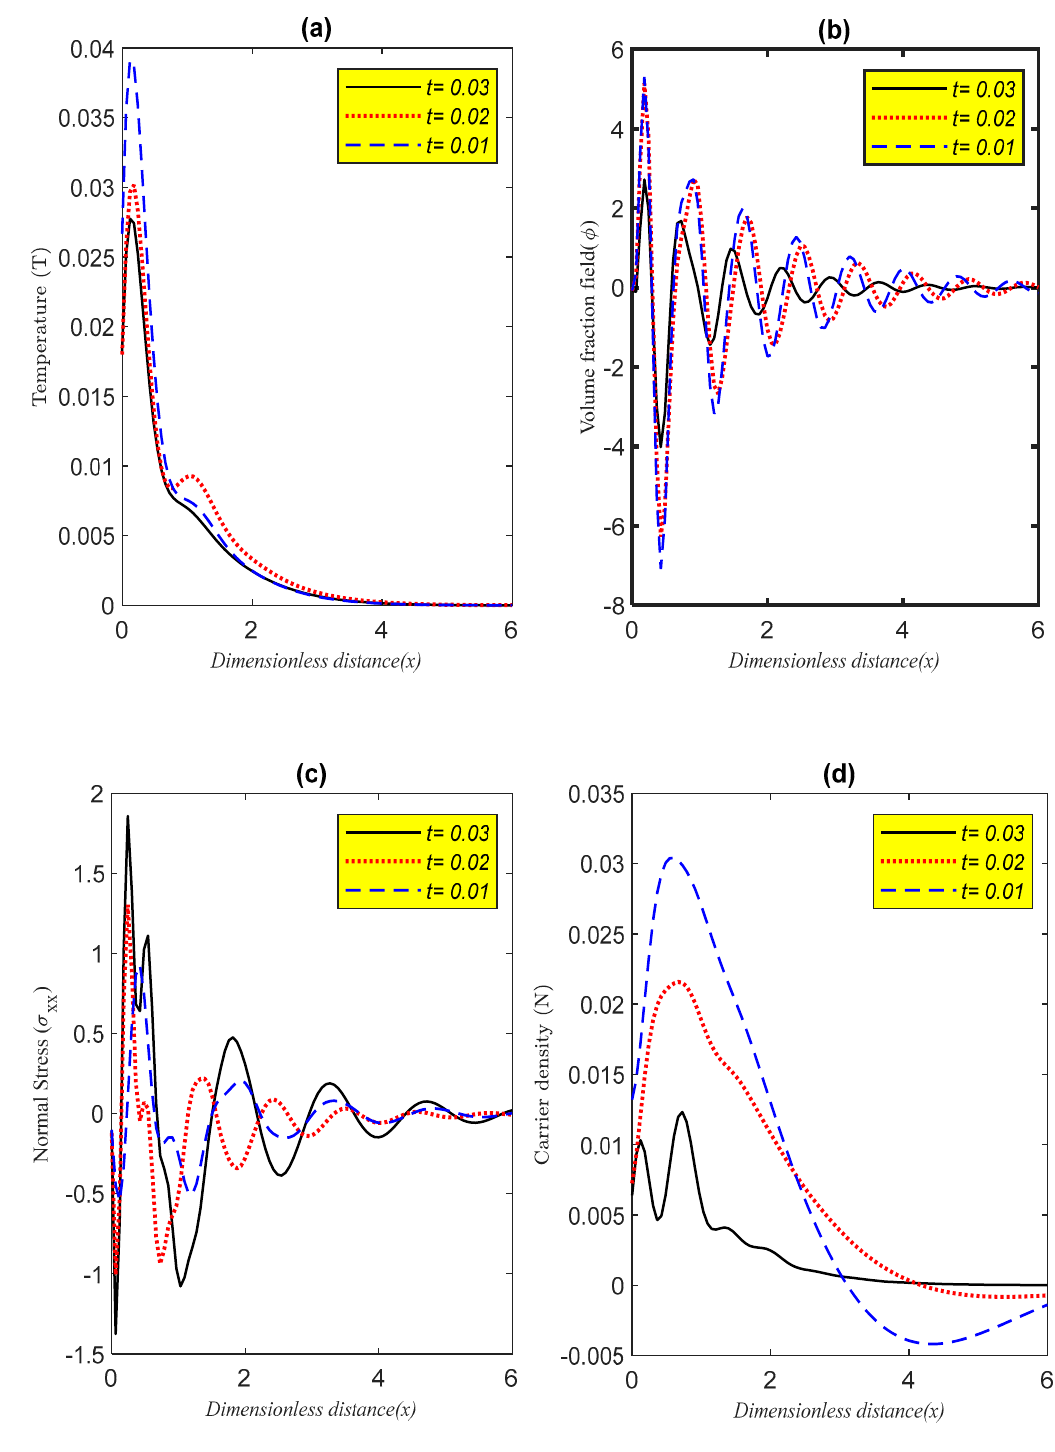
Figure 4. ( a–d ) The main physical wave’s fronts distribution at different dimensionless time in- stants.